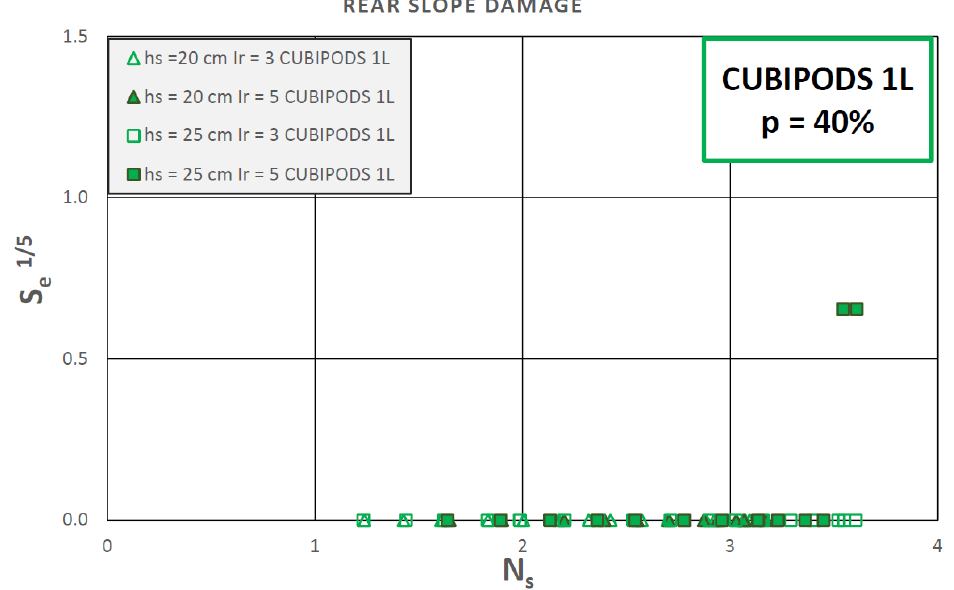
Figure 11. Measured armor damage, S e , to the rear slope as a function of the stability number (Cubipod ® armor).